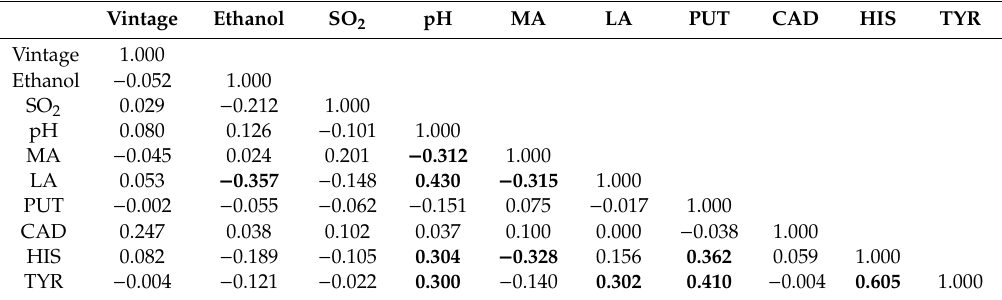
Table 7. Correlations between vintage, basic parameters and concentrations of biogenic amines in investigated